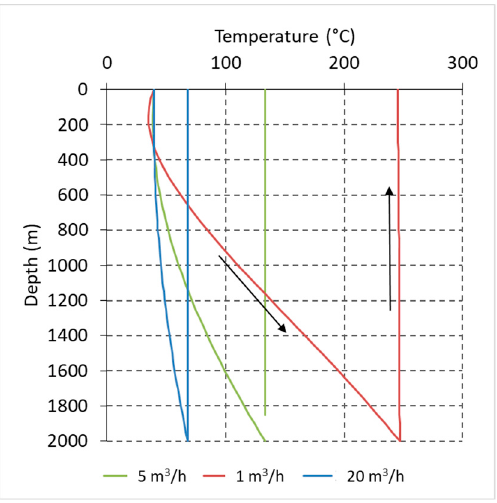
Figure 6. Temperature profiles for different flow rates in the DBHE (after one year from